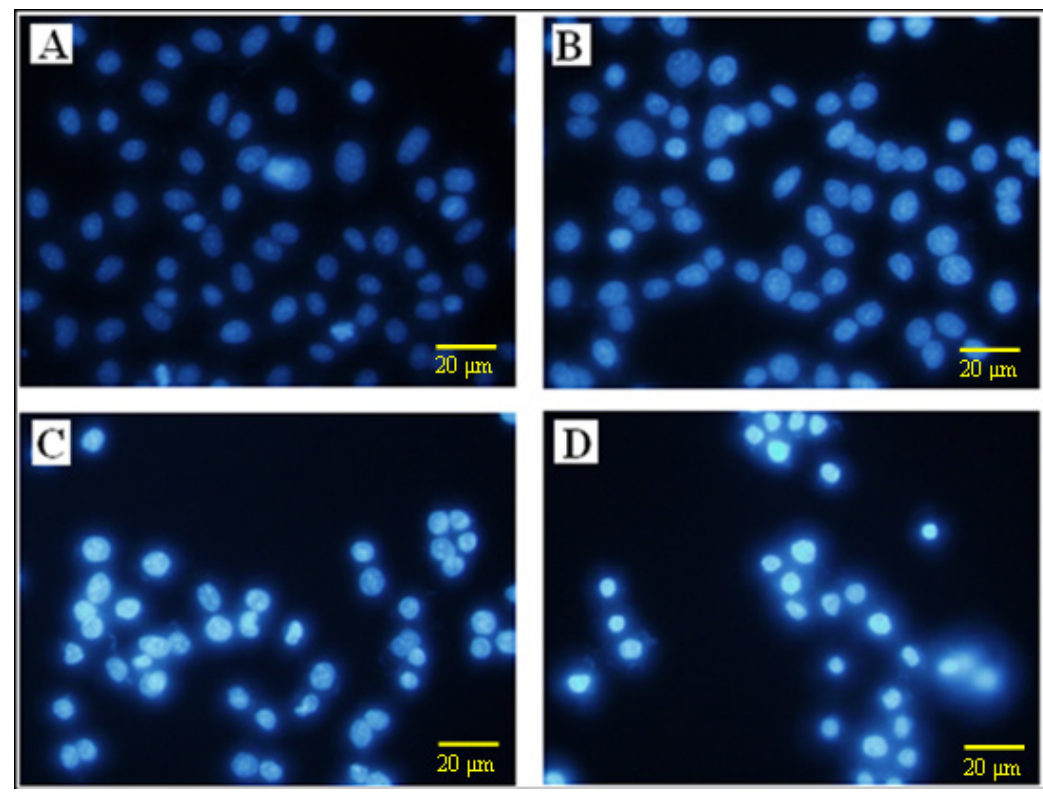
Figure 2. Determination of apoptosis in A549 cells by DAPI staining. Cells were treated with ATL-I at concentrations of 10, 20, and 40 μ M for 48 hours, then cells were stained by DAPI and observed by fluorescence photomicrography (× 200). A – D represent the control, 10 μ M, 20 μ M, and 40 μ M,